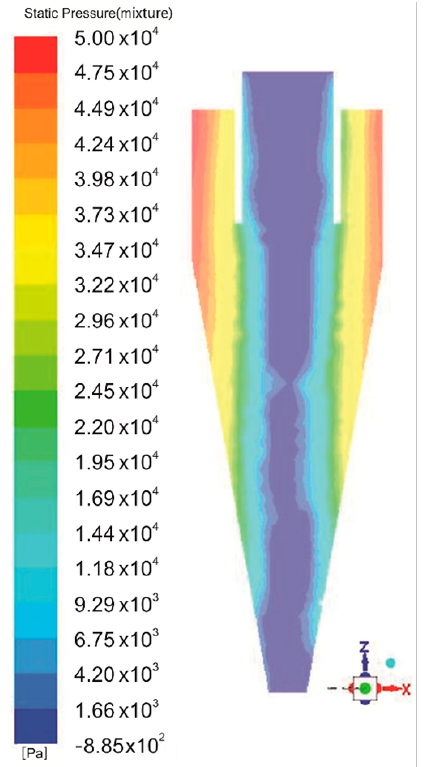
Figure 9. Contours of static pressure at plane y = 0 mm in CH with the inlet velocity of 5 m/s at the simulation time of 10 s. Processes 2021 , 9 , x FOR PEER REVIEW 12 of 14